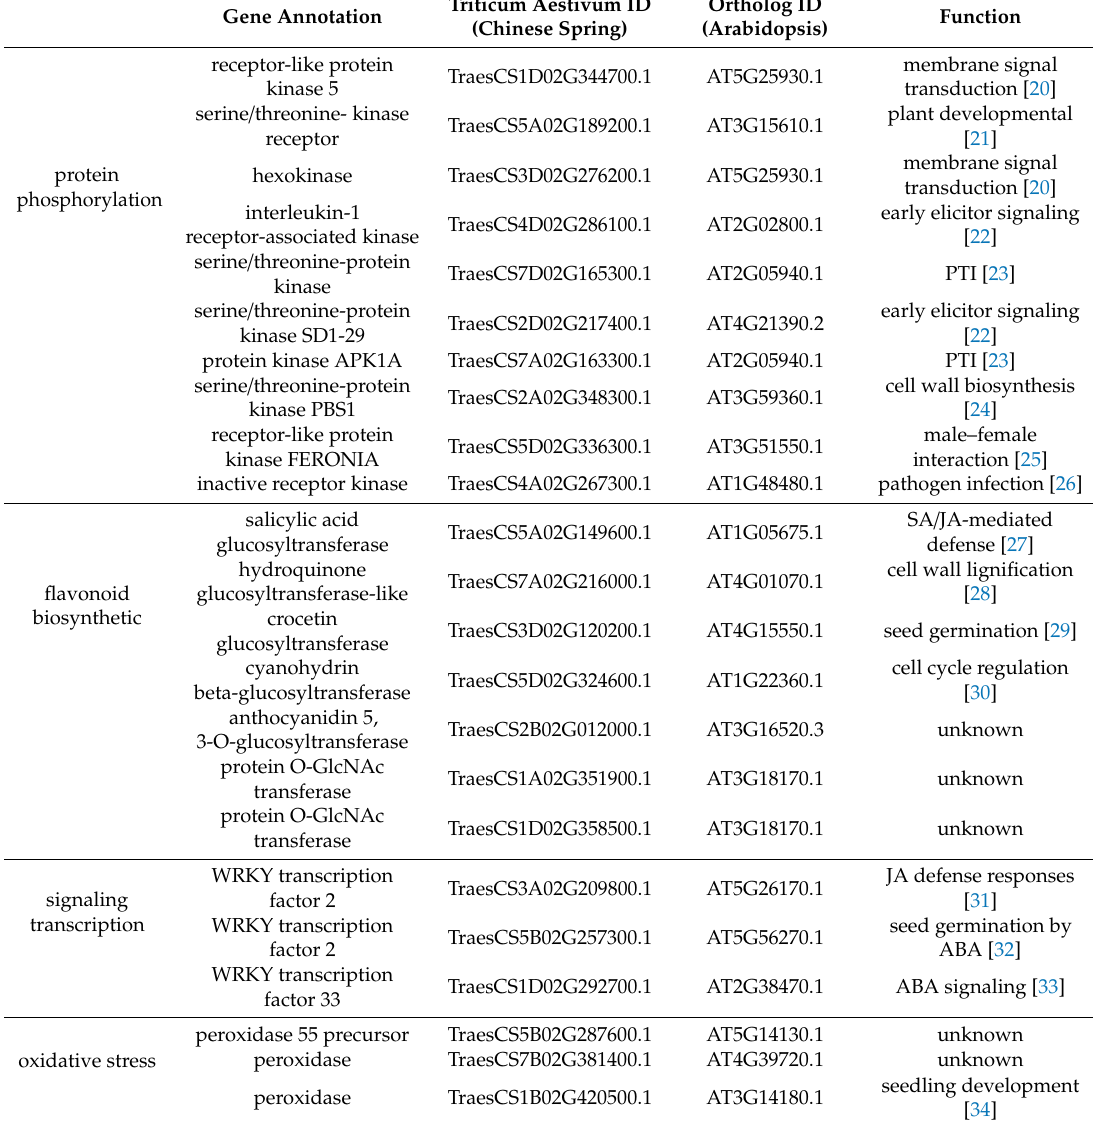
Table 1. Di ff erent expressed genes related with CMPG1-V